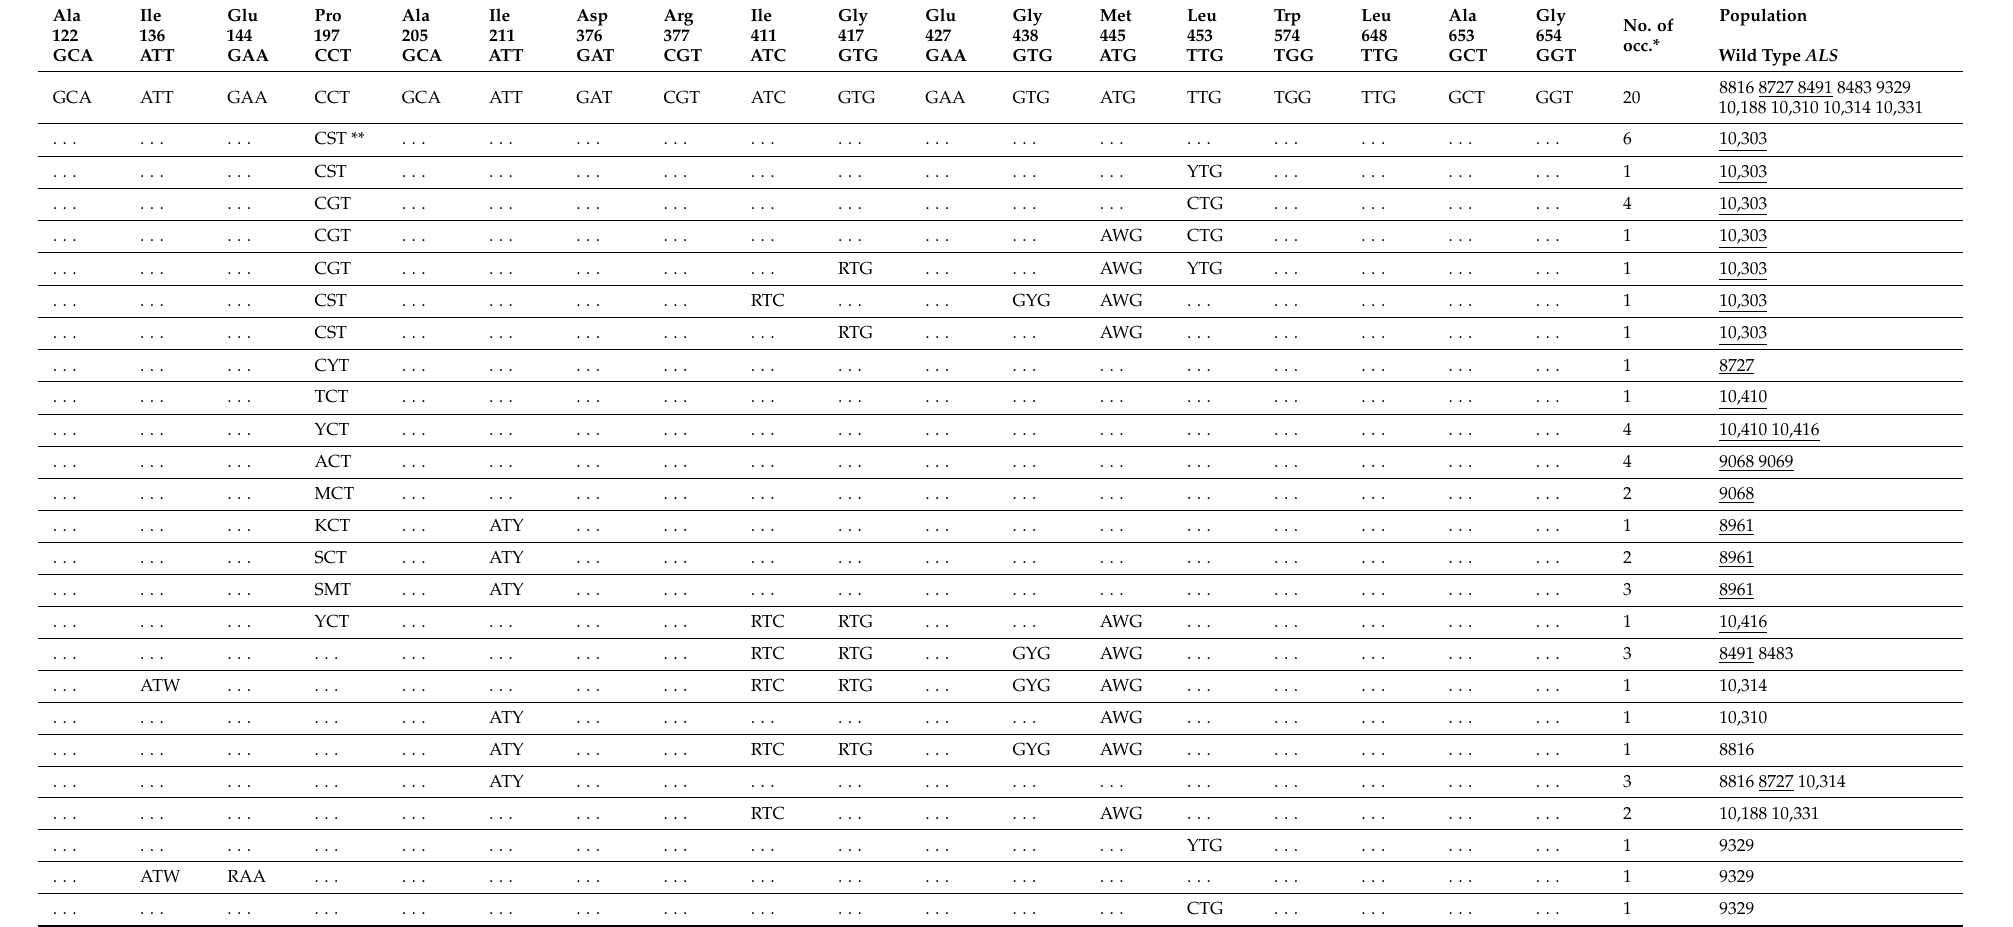
Table 3. Genetic variability in the acetolactate synthase of P. rhoeas populations. Only positions related to ALS resistance (Ala122, Pro197, Ala205, Asp376, Trp574, Ala653 and Gly654) and others where mutations were found are represented. All sequences were compared with the wild type P. rhoeas ALS gene (GenBank: AJ577316). IUPAC code was used for the nucleotide nomenclature. Dots indicate codons identical to those of the wild type ALS gene. ALS-resistant populations are